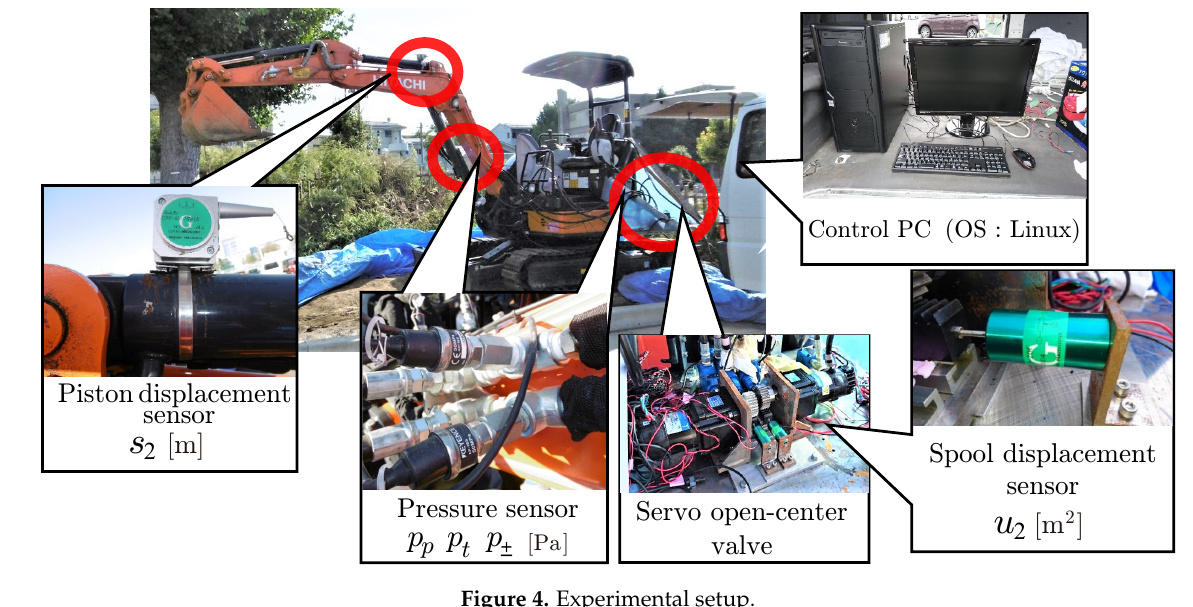
Figure 4. Experimental setup.